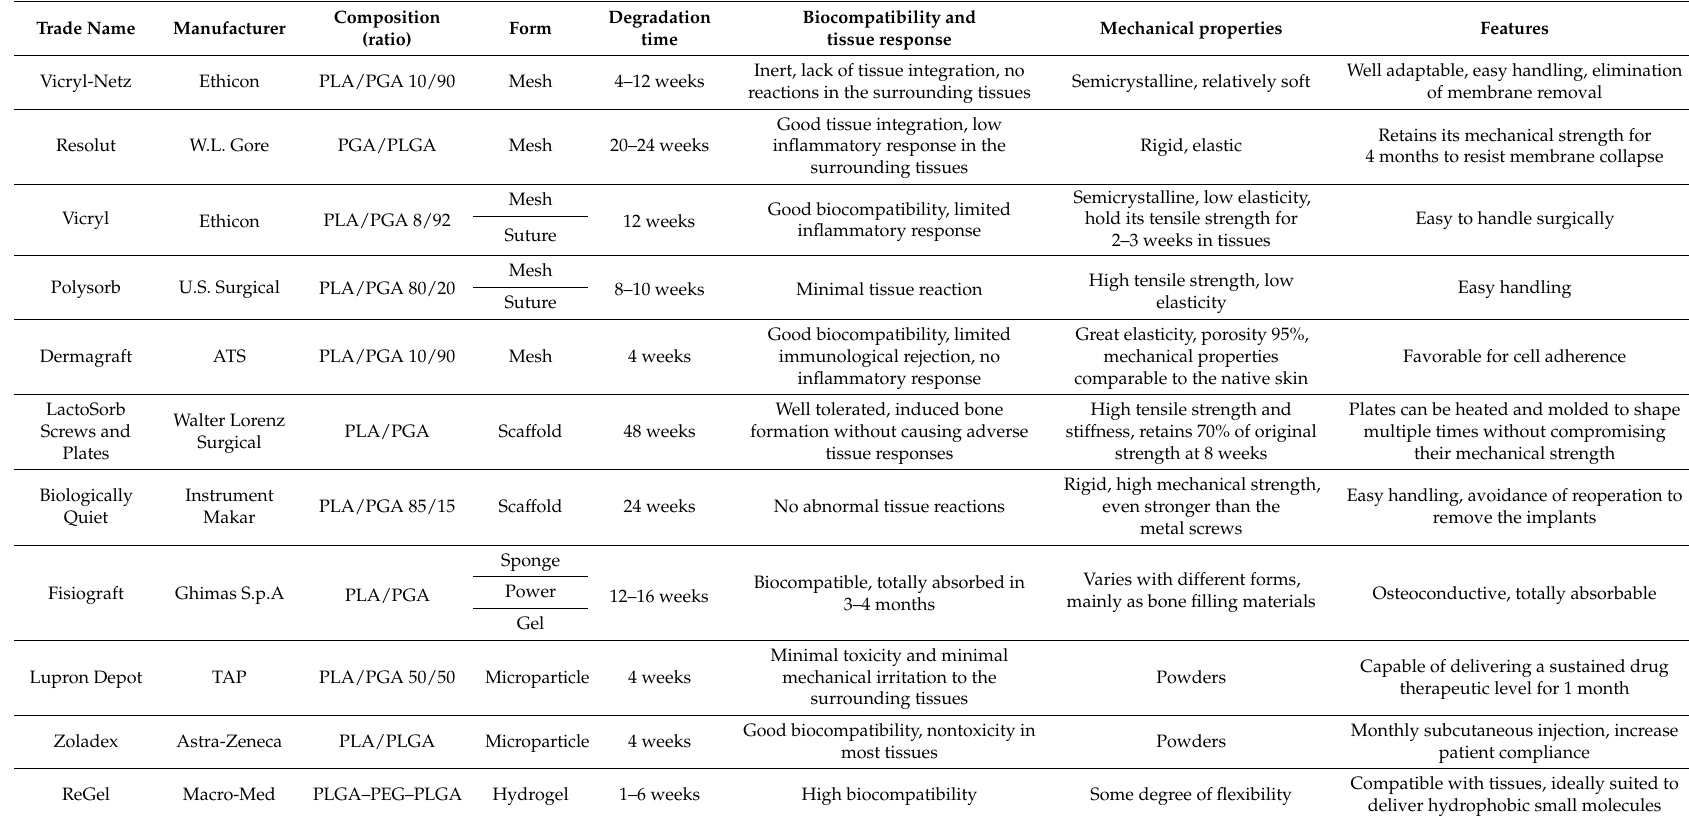
Table 1. Commercially available PLGA products for medical